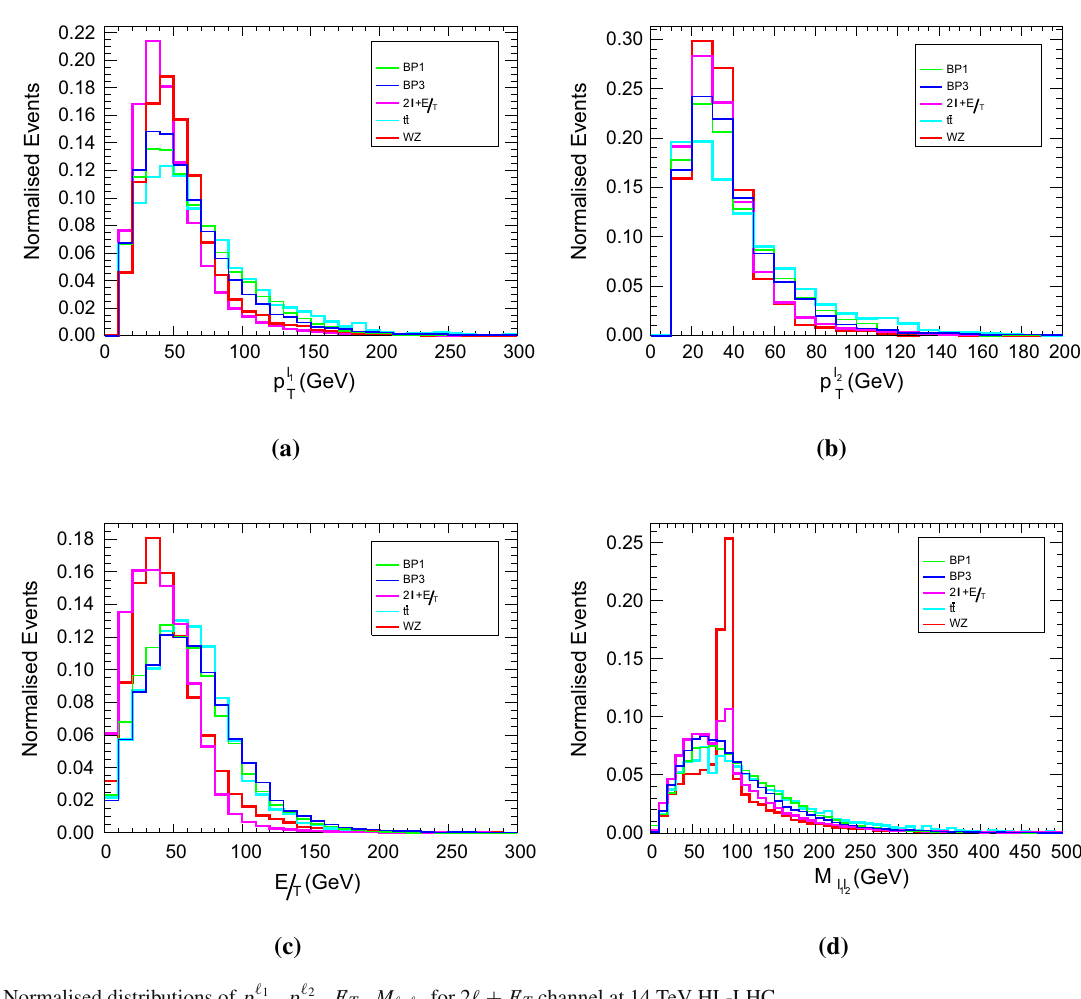
, p (cid:3) 2 , E / , M (cid:3) for 2 (cid:3) + E T / channel at 14 TeV HL-LHC T T T 1 (cid:3) 2